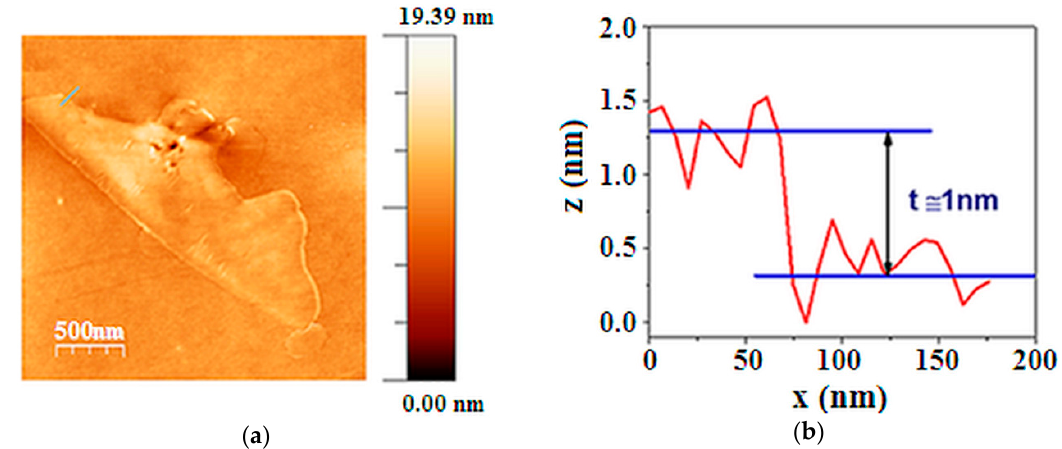
Figure 3. ( a ) 2D AFM image of graphenes (AFM Tapping mode Tip Radius < 10 nm); ( b ) Graphenes height profile.